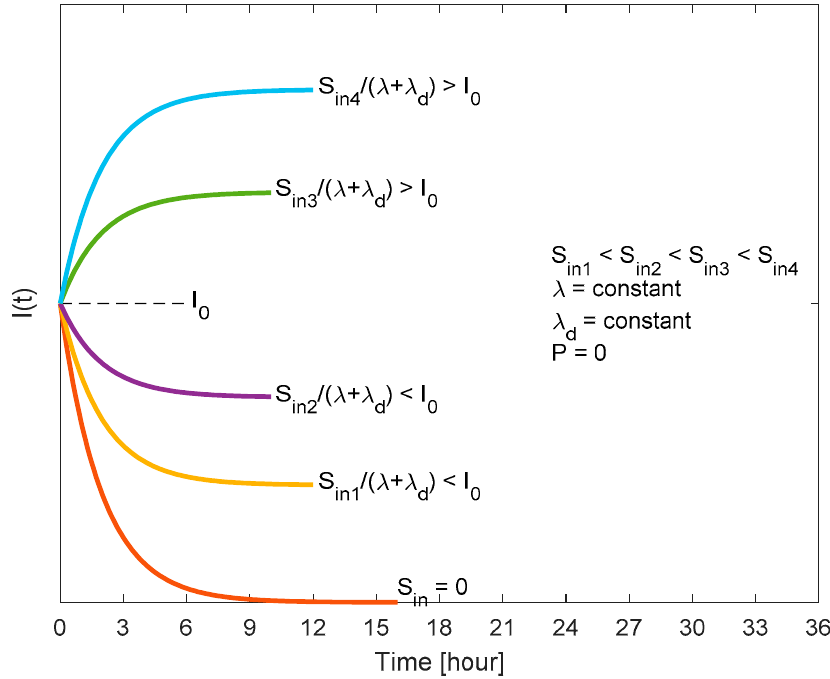
Figure A4. Role of the ventilation rate ( S in ) on the steady state indoor aerosol concentration. All other indoor aerosol parameters— λ , λ d , and P— are held constant as shown in the figure.